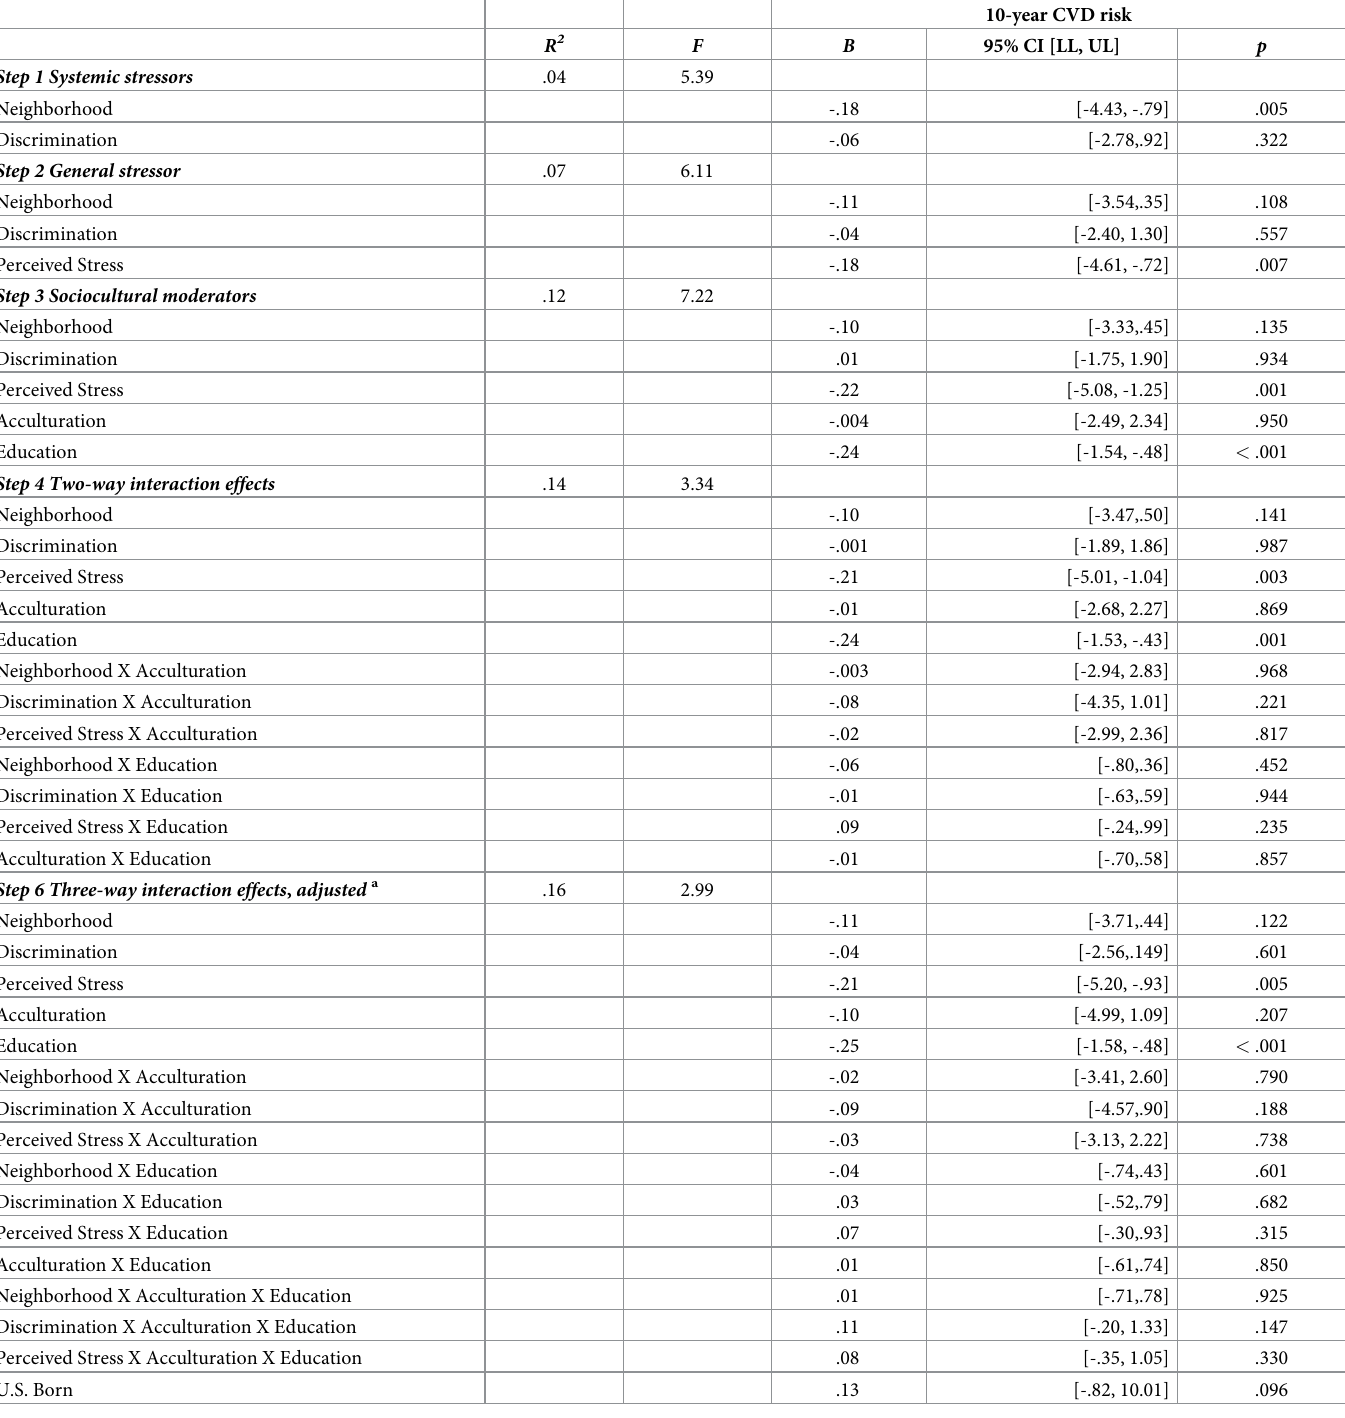
Table 3. Hierarchical main and interaction effects of psychological stress, acculturation, and education on 10-year CVD risk ( n =